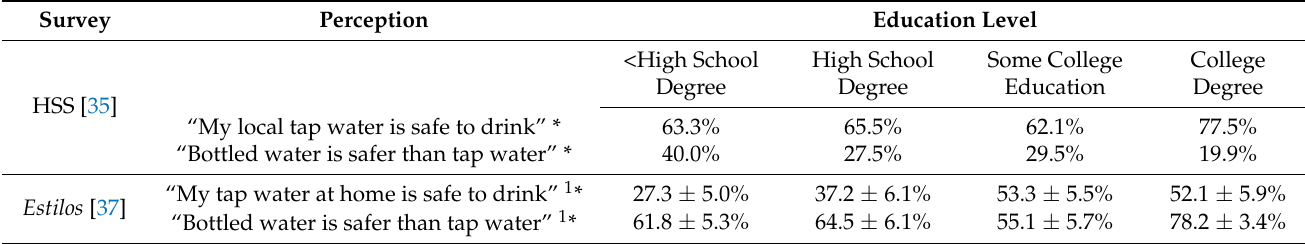
Table 7. Prevalence of agreement with perceptions by education level among survey